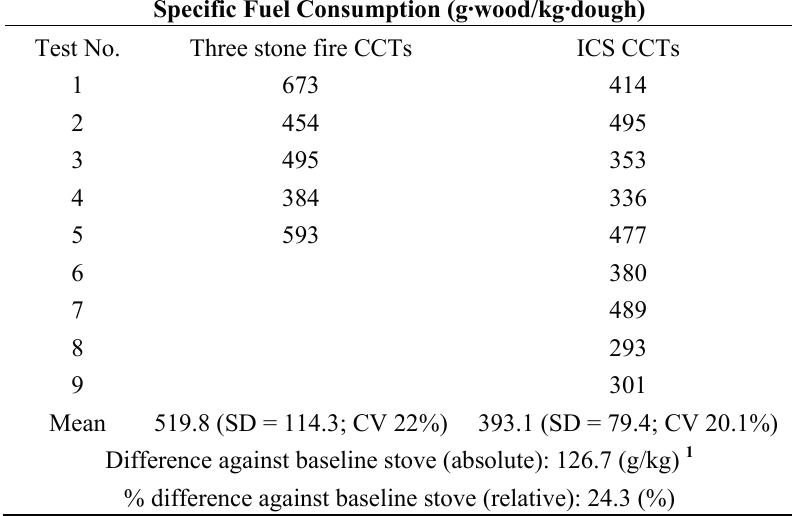
Table 6. Results of efficiency testing according to controlled cooking test (CCT) per injera